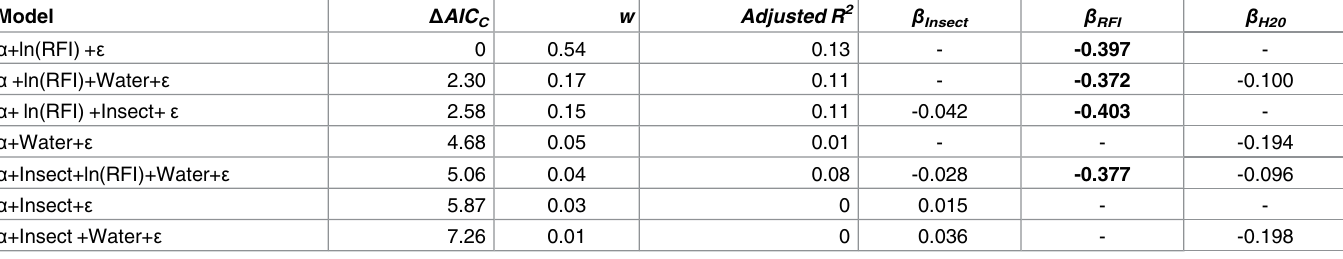
Table 2. Models predicting hybridization rate between Raphanus raphanistrum and R . sativus based on plot-level soil moisture, relative flowering intensity, and the relative frequency that insect visitors switched from foraging on R . raphanistrum and went to R . sativus as predictors (for clarity the intercept ( α ) and error ( ε ) are included in all models).